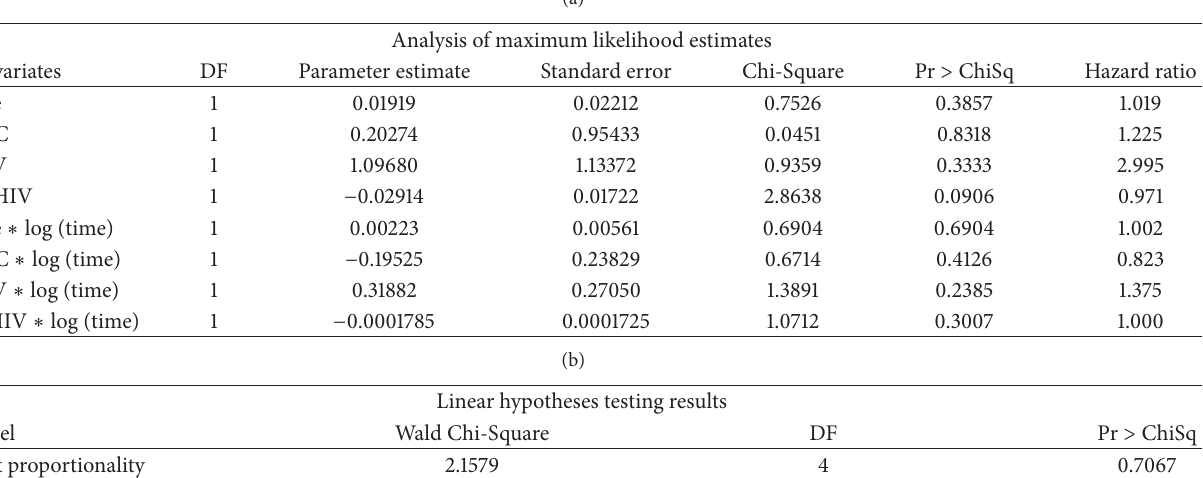
Table 8: Result of test of proportionality assumption containing the variables in Table 7 and their interaction with log